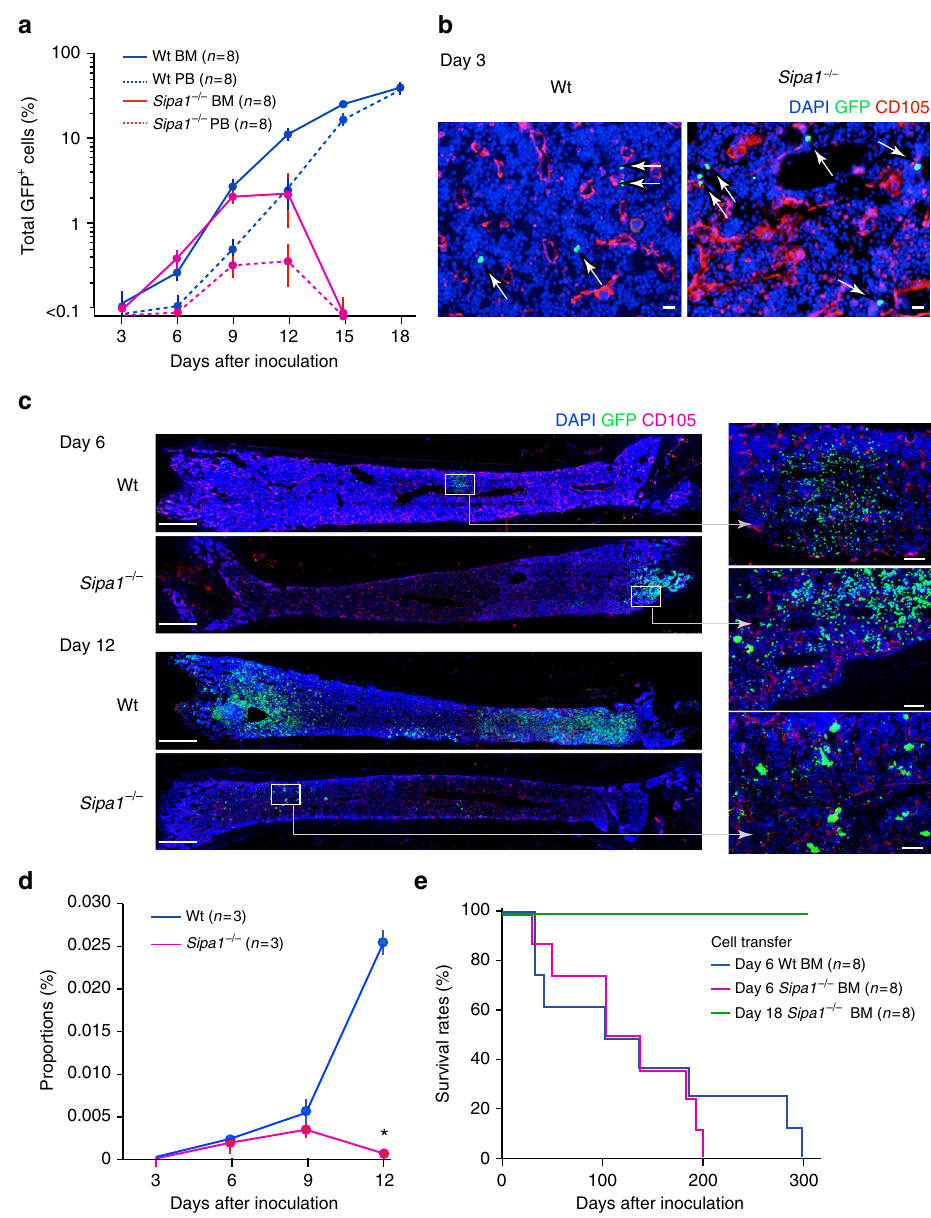
Fig. 2 Bcr-Abl + HPCs home to and initiate proliferation in BM but are eventually rejected in the Sipa1 − / − host. a Bcr-Abl + HPCs were intravenously injected into unirradiated Wt and Sipa1 − / − mice, and the proportions of GFP + cells in the BM and PB were assessed with FACS on varying days after injection. The means and standard errors (SEs) of eight mice are shown. The experiments were performed twice with similar results. b On day 3 after injection with Bcr- Abl + HPCs, BMs were immunostained with DAPI, anti-GFP antibody, and anti-CD105 antibody for endothelial cells. Arrows indicate the injected GFP + cells in the BM parenchyme. Scale bars, 20 μ m. Similar results were con fi rmed in three mice of each group. c On days 6 and 12, BMs were immunostained with DAPI, anti-GFP, and anti-CD105 antibodies. The enlarged images of boxed regions are also shown. Scale bars, 1 mm and 100 μ m (enlarged). Similar results were obtained in three mice of each group. d The proportions of GFP + Lin − cKit + Sca-1 + (LKS) cells in the BM of Wt and Sipa1 − / − mice were assessed with FACS at varying days after injection of Bcr-Abl + HPCs. The means and SEs of three mice per group are shown. * p < 0.01 (two-tailed unpaired Student ’ s t -test). e BM cells from Wt and Sipa1 − / − mice that received Bcr-Abl + HPCs were harvested on day 6 and day 18, and intravenously injected into the secondary unirradiated Wt B6 mice on a one-to-one basis. Survival curves of eight recipients per group are Sipa1 − / − mice to Bcr-Abl + HPCs, we performed genetic studies. host. Sipa1 − / − mice were no more resistant than Wt mice against − / − unrelated leukemia cell lines, such as the T-ALL cell line Wo1, The resistance of Sipa1 mice was completely abolished by the which also expresses GFP, and the T-cell leukemia cell line EL4 introduction of the Rag2 − / − genetic background (Fig. 4a). (Fig. 3c), and thus the resistance was apparently selective for Bcr- Sipa1 − / − CD3 ε − / − mice also developed lethal CML comparably Abl + cells. to Wt mice, whereas all Sipa1 − / − μ MT − / − mice remained disease free for more than 100 days (Fig. 4b, c). Notably, both Sipa1 + / + Sipa1 − / − T cells are essential for the CML resistance . To Rag2 − / − and Sipa1 + / + CD3 ε − / − mice were by no means more susceptible than Wt mice, suggesting that T cells play little role in identify the hematopoietic cells involved in the resistance of